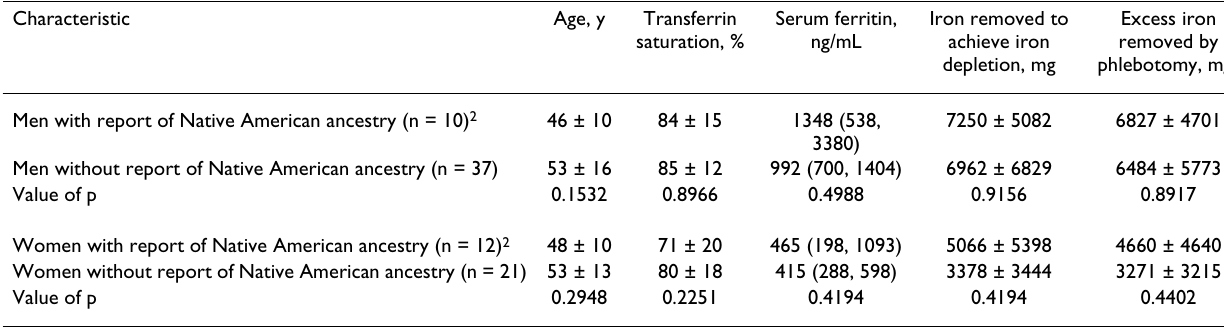
Table 1: Characteristics of Alabama hemochromatosis probands with HFE C282Y homozygosity 1